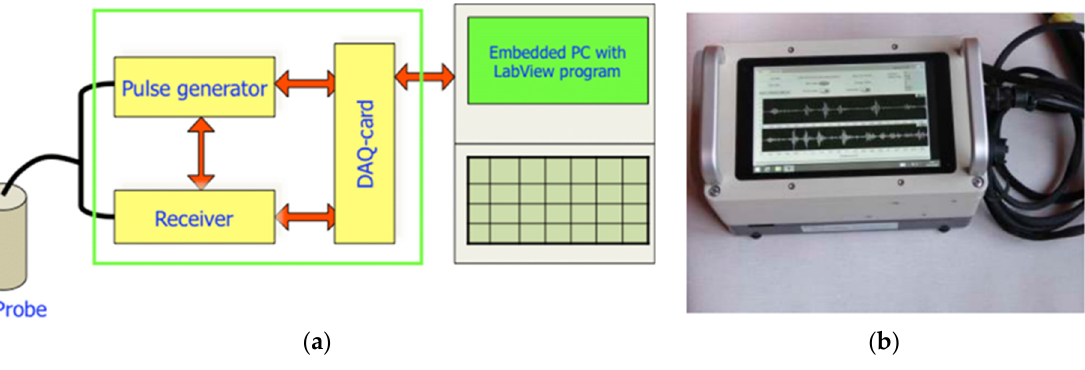
Figure 3. ( a ) Block diagram of RBT instrument; ( b ) RBT [15].